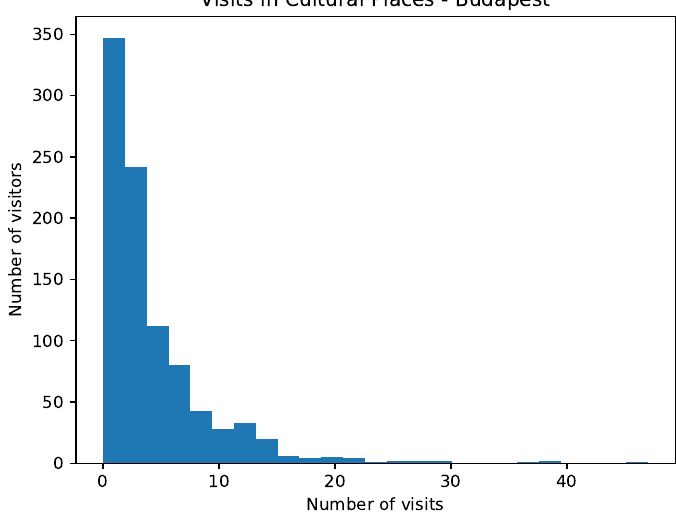
Figure 3. Histogram of the number of distinct visits to cultural places in